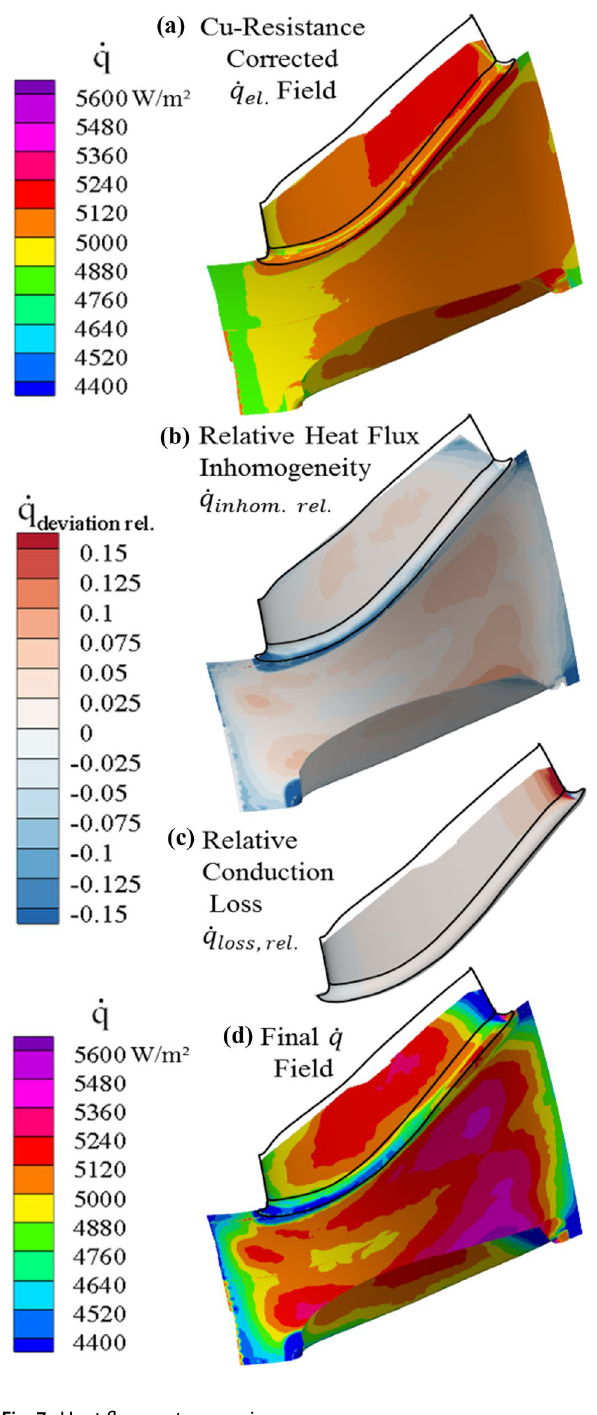
Fig. 7 Heat flux postprocessing